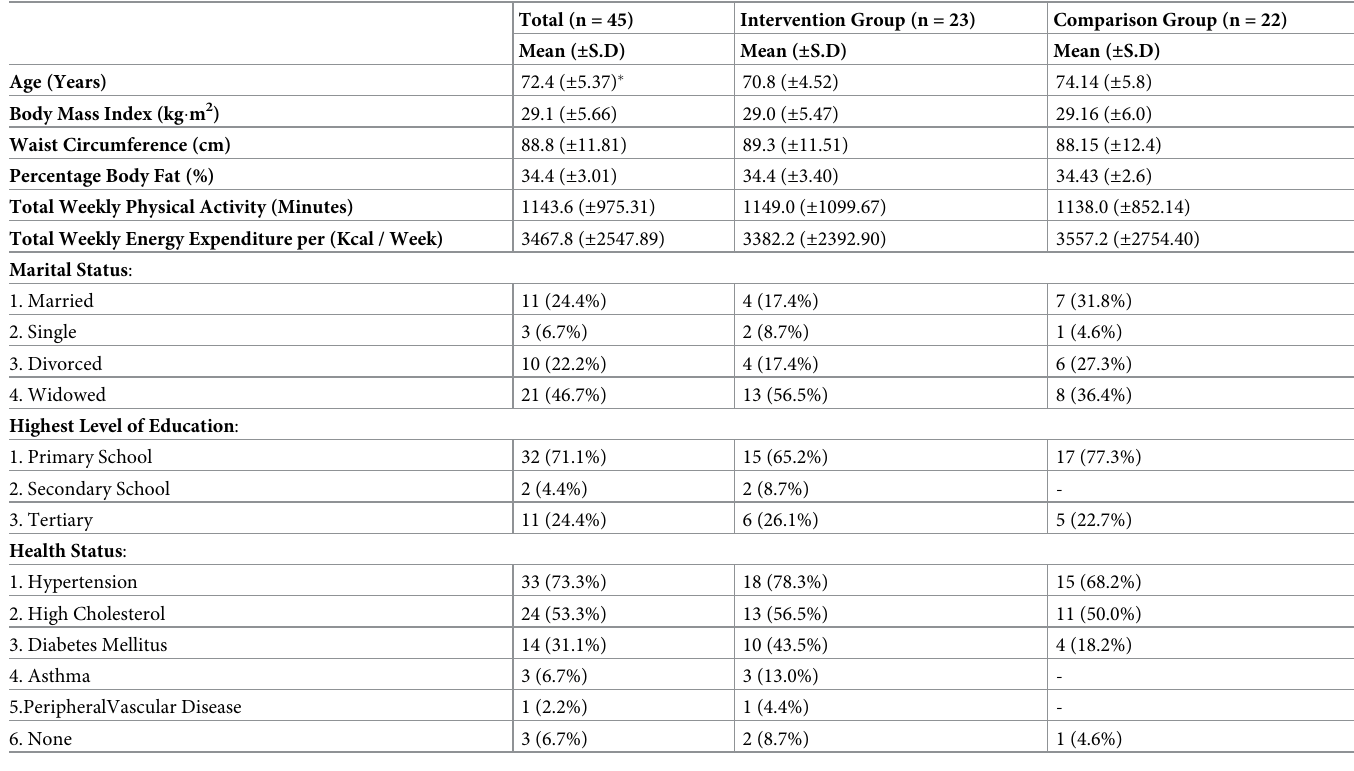
Table 5. Baseline demographic and health